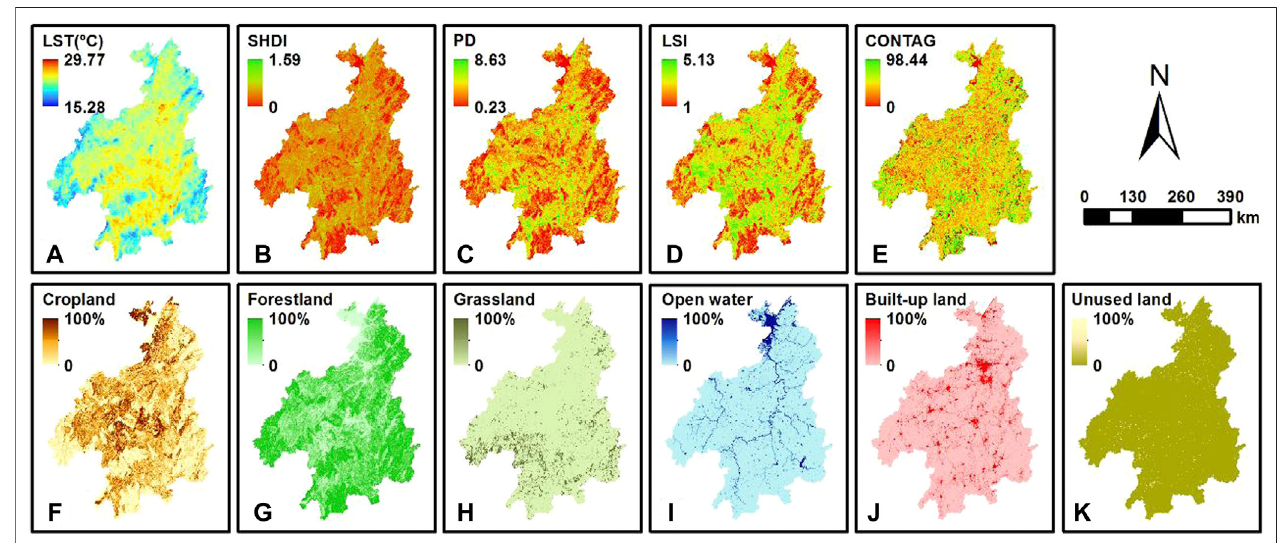
FIGURE3| Spatialpatterns oflandcovertypesand landscapemetricsin2017. (A) LST, (B) SHDI, (C) PD, (D) LSI, (E) CONTAG, (F) Cropland, (G) Forestland, (H) Grassland, (I) Open water, (J) Built-up land, (K) Unused land.